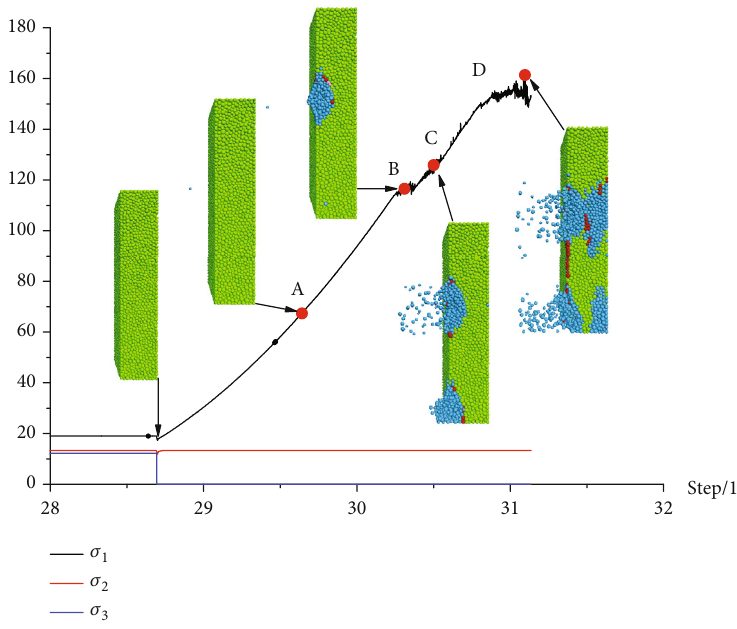
Figure 9: Rock burst failure process of the